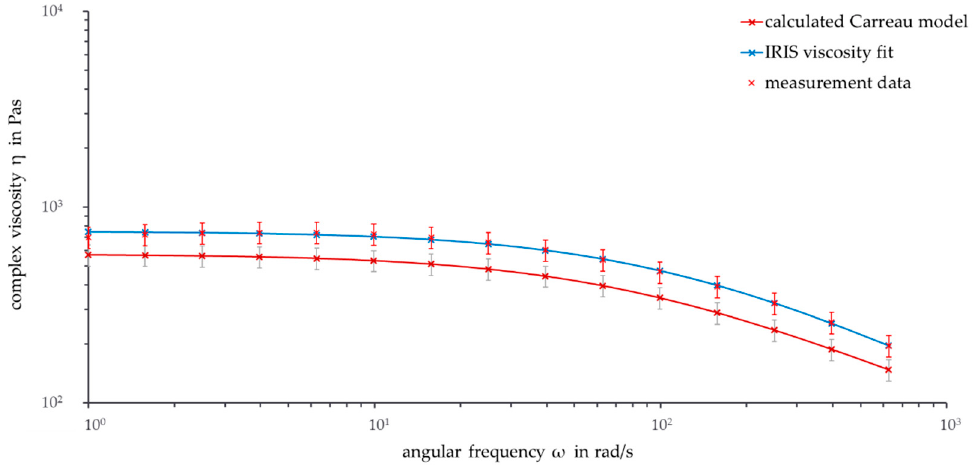
Figure 6. Frequency sweep: Calculated Carreau model, IRIS viscosity fit, and measurement data ( ϑ = 190 °C, ω = 1–628 rad/s).